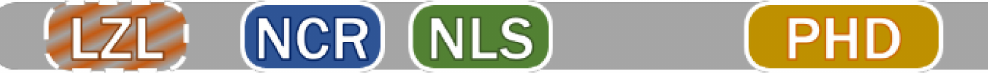
Figure 1. Linear representation of ING proteins sequence. The LZL motif (orange striped) that allows the interaction with other proteins is present on ING2, ING3, ING4 and ING5 but not ING1. The NCR domain (blue), specific to the ING family, is shared between all the INGs. The NLS domain (green) is responsible for the nuclear localization of the protein and the PHD motif (yellow) for the binding to methylated